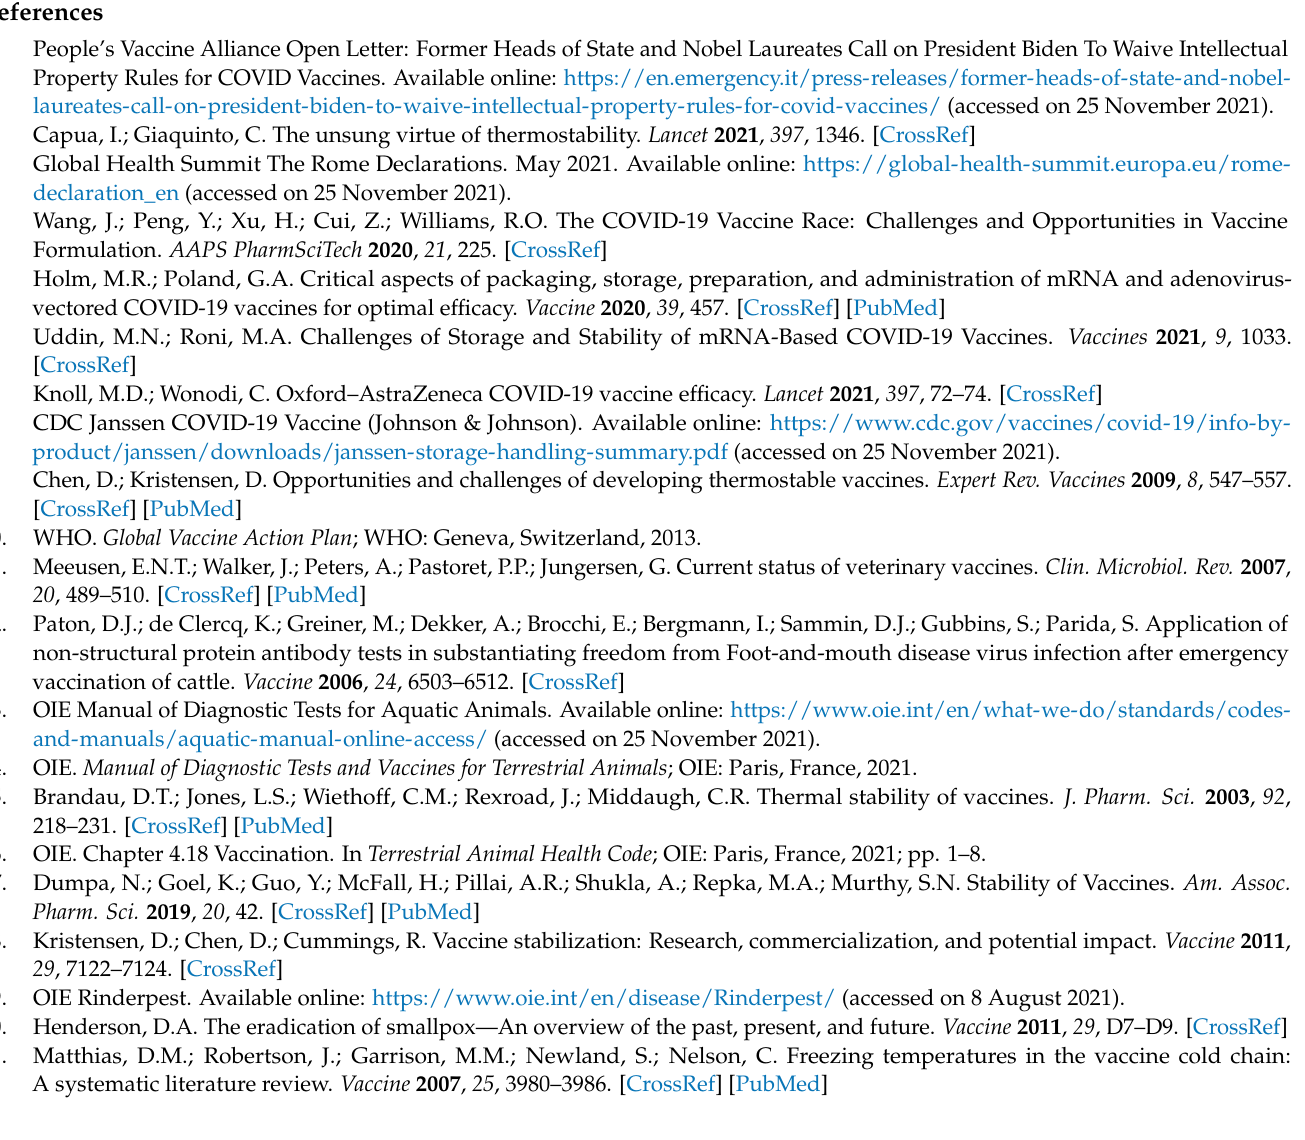
Figure A3. Funnel plot of the meta-analysis on vaccines